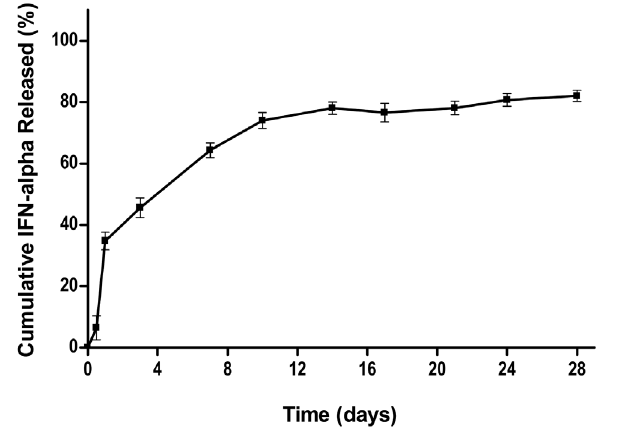
FIGURE 2 - Cumulative interferon-alpha release from poly-ε- caprolactone microspheres co-encapsulated with human serum albumin (Values shown as mean ± standard deviation, n = 6; p<